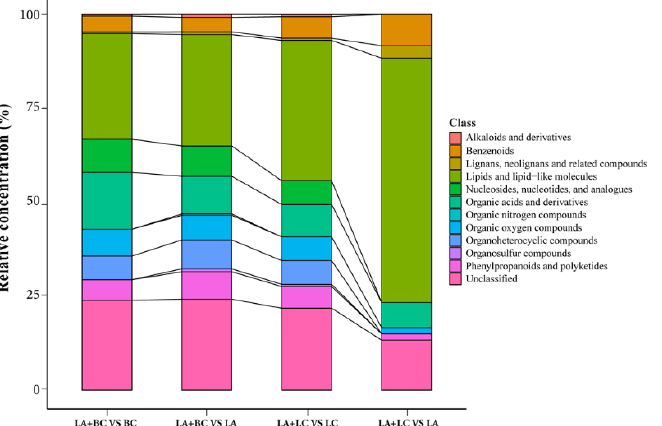
Figure 5. Analysis of differentially expressed metabolites between co-culture and mono-culture biocontrol agents. LA+BC vs. BC: Lysobacter antibioticus 13-6 and Bacillus cereus BT-23 co-culture vs. B. cereus BT-23; LA+BC vs. LA: L. antibioticus 13-6 and B. cereus BT-23 co-culture vs. L. antibioticus 13-6; LA+LC vs. LC: L. antibioticus 13-6 and L. capsici ZST1-2 co-culture vs. L. capsici ZST1-2; LA+LC vs. LA: L. antibioticus 13-6 and L. capsici ZST1-2 co-culture vs. L. antibioticus 13-6.